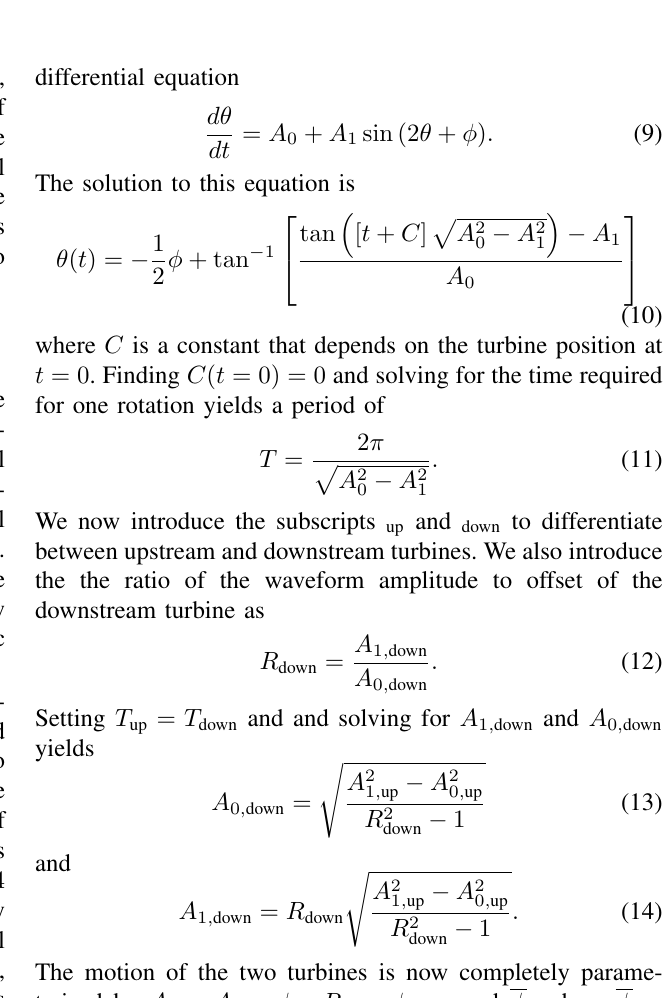
Fig. 4. Results from the intracycle angular velocity control optimization. Left: Optimum control parameters for the schemes tested, as well as their respective mean efficiencies ( C P ). The semi-arbitrary control scheme shows a 59% increase in efficiency over the constant angular velocity controller. Right: Tip-speed ratio profiles of the optimum control schemes. A half revolution is presented as the profiles are twice periodic over a single turbine revolution. Note that the mean efficiency values presented are identical whether the total or fluid torque is used due to the angular velocity